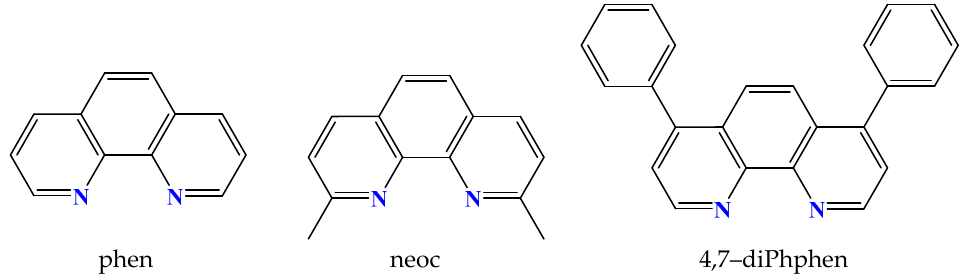
Figure 10. The syntax formula of phenanthroline derivatives: phen = 1,10–phenanthroline; neoc = neocuproine = 2,9–dimethyl–1,10–phenanthroline and 4,7–diPhphen = 4,7–diphenyl–1,10–phenan- throline.